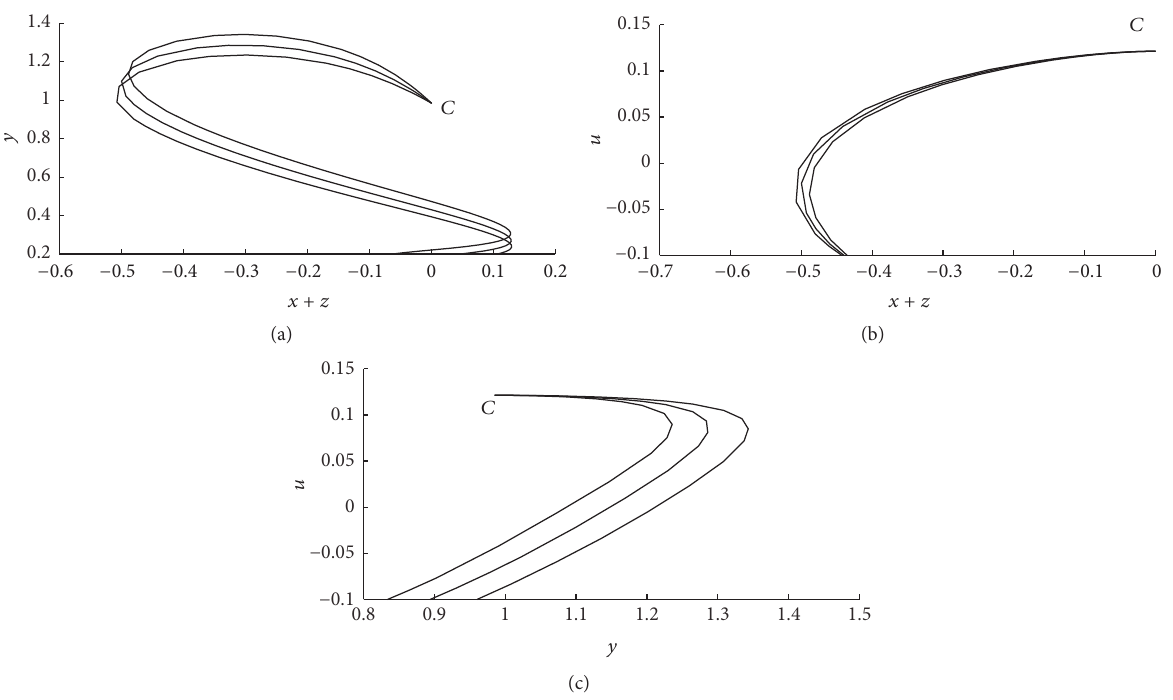
Figure3:Two-dimensionalprojectionsofthephase-spacetrajectoriesforstabilityconditions 𝜉 = 2 , 𝜆 = 1 andforpresentdayvalues 𝛽 = 14.5 , = 0.3 . All plots begin from the critical point 𝐶 being a stable attractor. Ω 𝑚